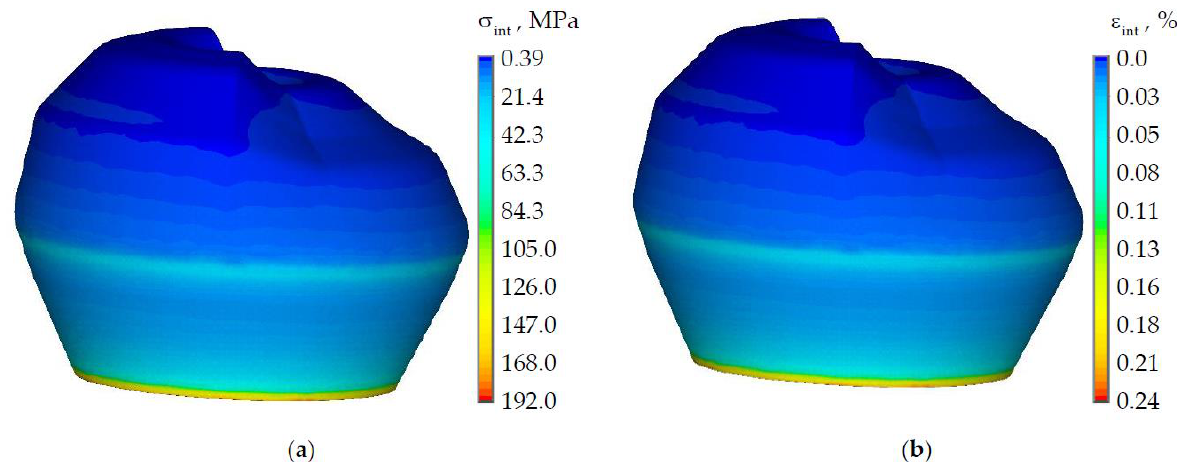
Figure 4. Stress and strain intensity of the tooth without NCCL: ( a ) is stress intensity; ( b ) is strain